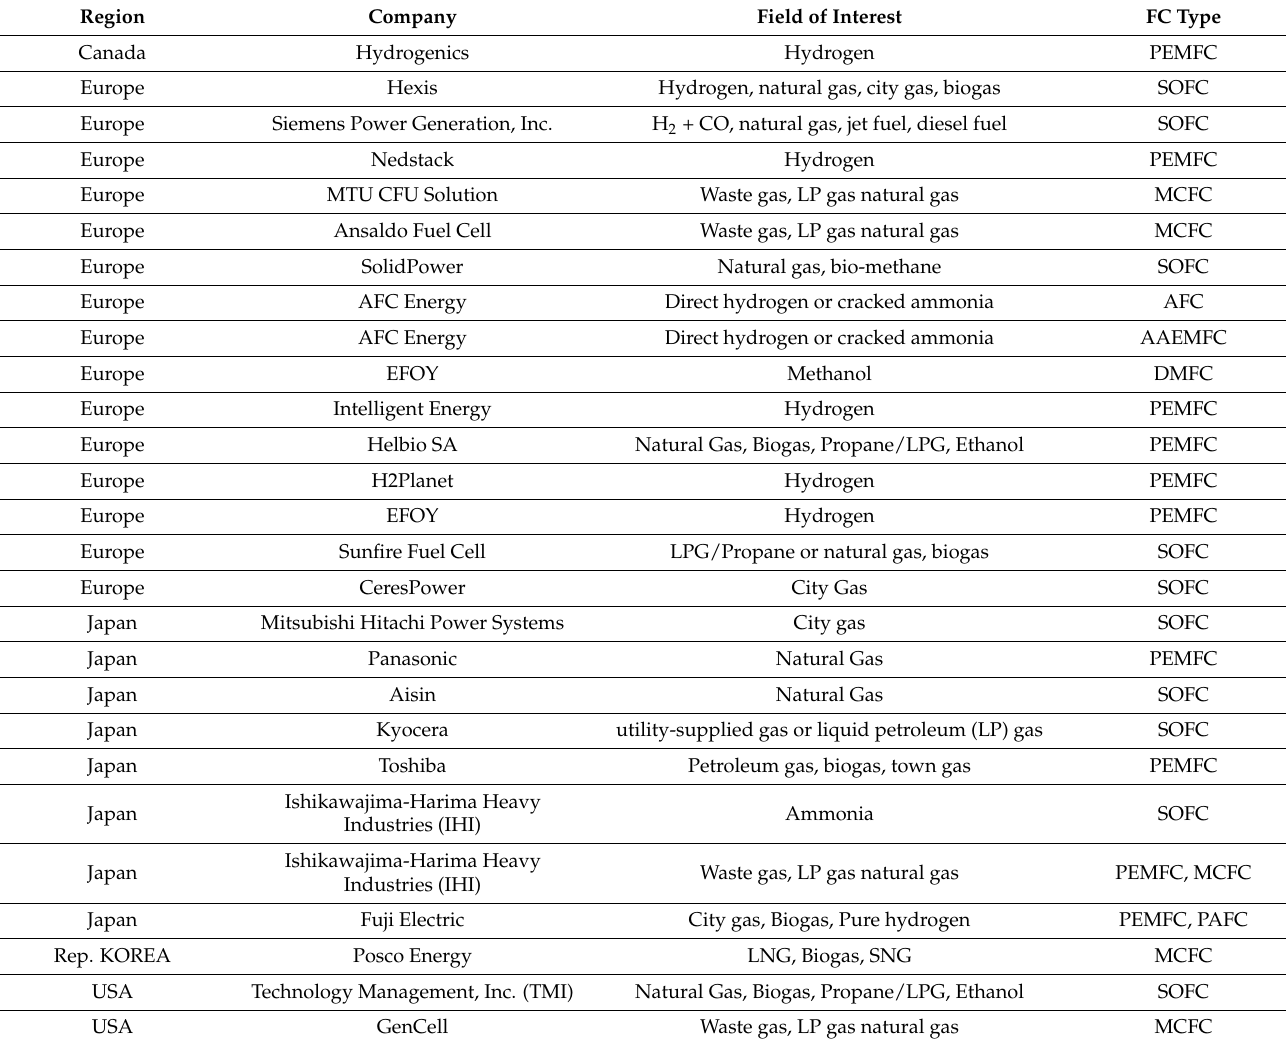
Table 4. Zoom-in on important big players around the world on fuel